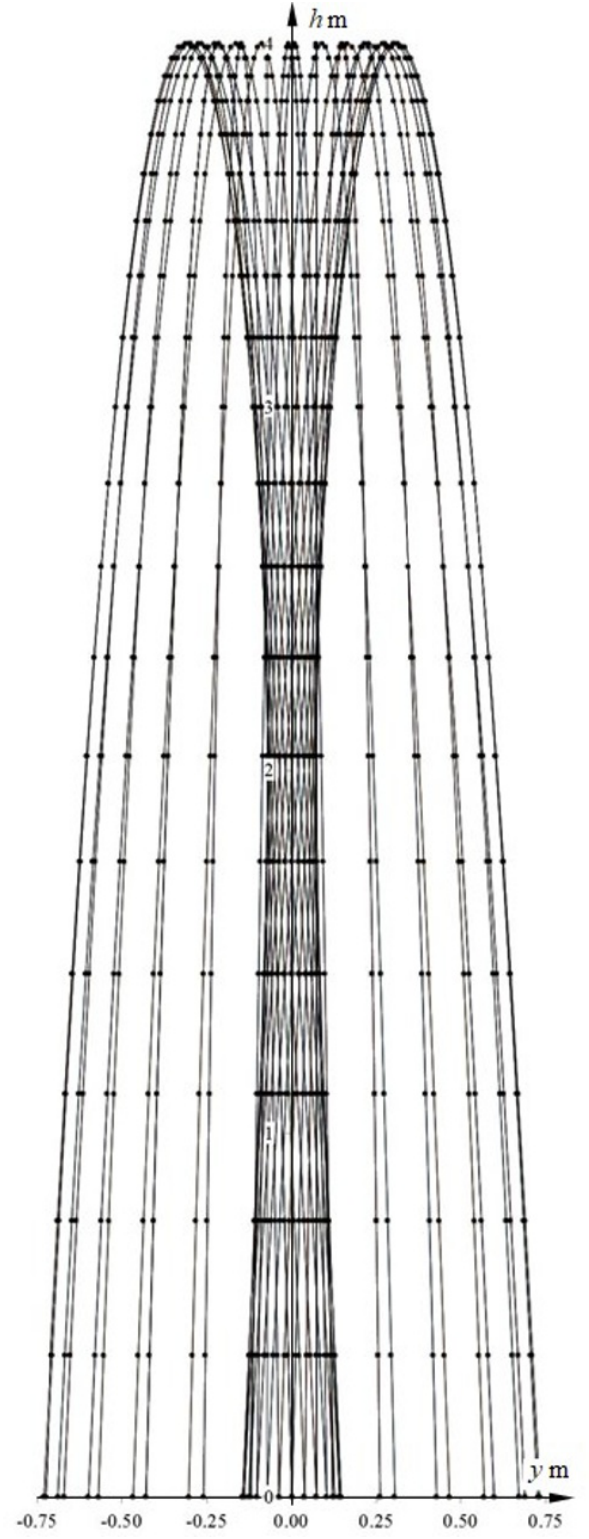
Fig. 10 . Simulation